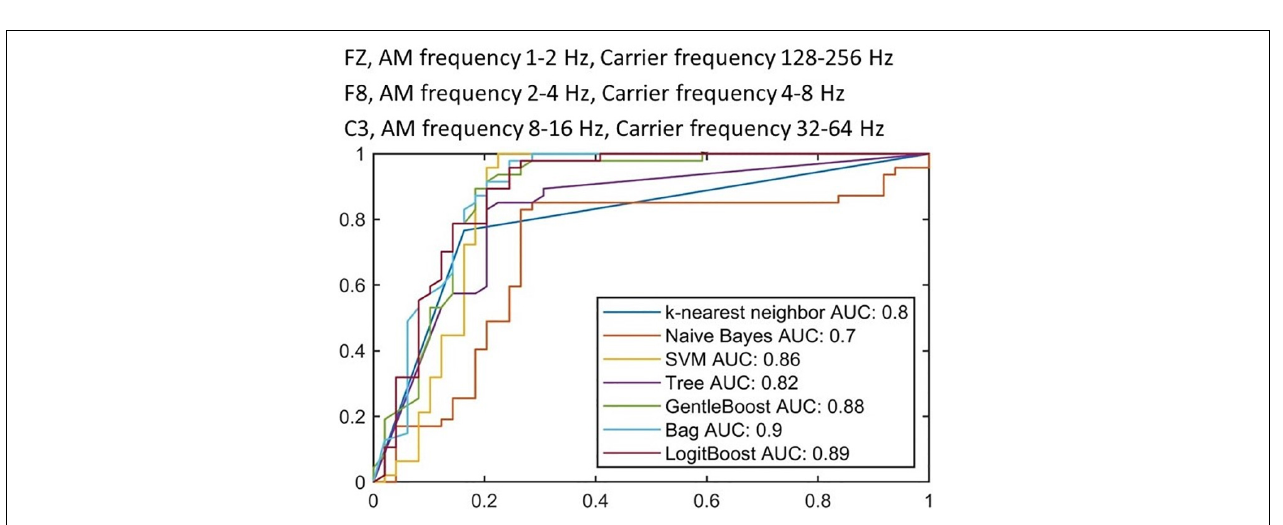
FIGURE 5 | Receiver operating characteristic curves from training stage with 10-fold cross validation. Each ROC curve represents a candidate algorithm (the AUC of all algorithms are higher than 0.7).